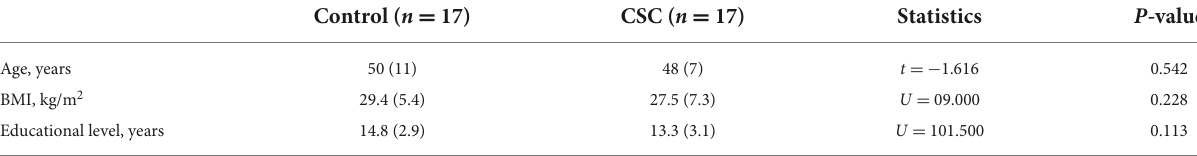
TABLE 1 Somatic and demographic characteristics of the study